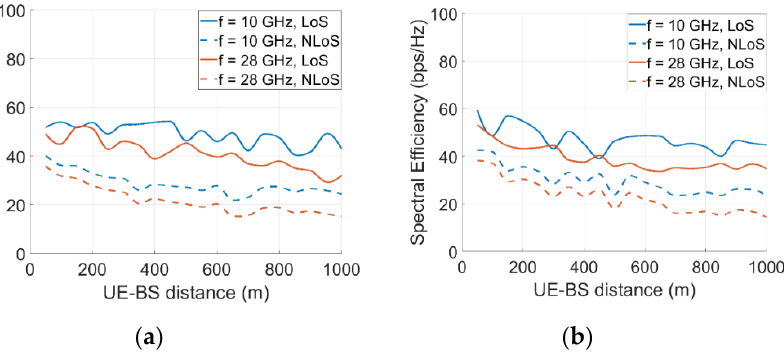
Figure 5. Spectral efficiency of a D-MIMO (50 × 10) system for two frequencies (10 GHz and 28